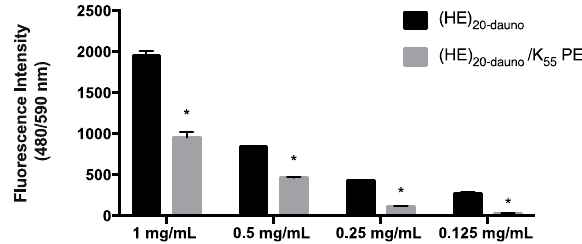
Figure 5. Fluorescence quenching of daunomycin in (HE) 20-dauno /K 55 PEC. Fluorescence measurements were taken of the (HE) 20-dauno solution alone and the (HE) 20-dauno /K 55 PEC. There is a significant decrease in fluorescence signal from daunomycin at all concentrations of PEC. The data shown are averages over 4 wells ± standard deviation. Results were analyzed by the Student’s t -test, with p < 0.001 indicated (*). Table 1. Encapsulation efficiency and loading content of daunomycin in (HE) 20-dauno /K 55 PEC. Fluorescence measurements were taken of the daunomycin solution alone and the (HE) 20-dauno /K 55 PEC. The ratio between free drug and drug encapsulated within the PEC was used to determine the encapsulation efficiency and loading content.